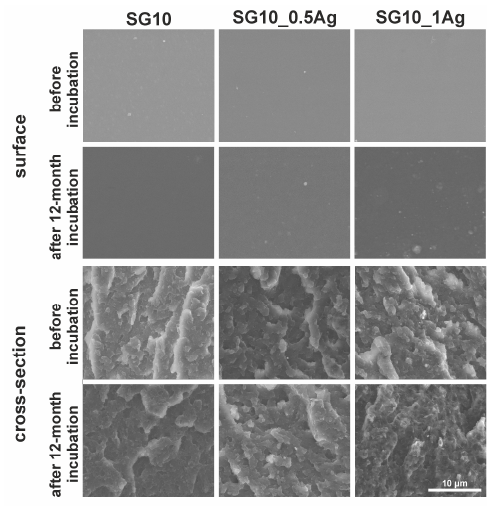
Figure 2. SEM images of surface and cross-section of the SG10-based materials before and after 12-month incubation in deionized water.